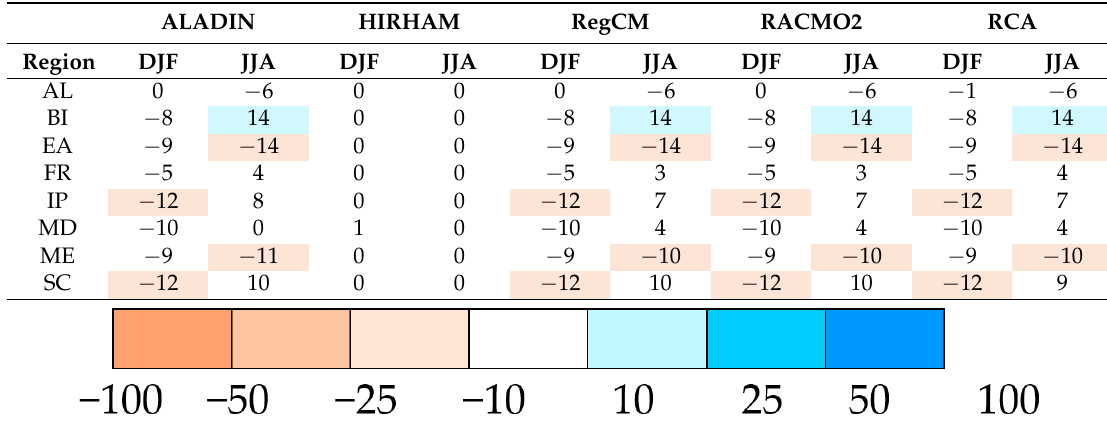
Table 5. Residual bias of seasonal amount of simulated precipitation in the case of power transformation of the precipitation bias correction method in eight different regions: the Alps (AL), the British Isles (BI), Eastern Europe (EA), France (FR), the Iberian Peninsula (IP), the Mediterranean (MD), Mid-Europe (ME) and Scandinavia (SC) in DJF and JJA. The bias values are in %.